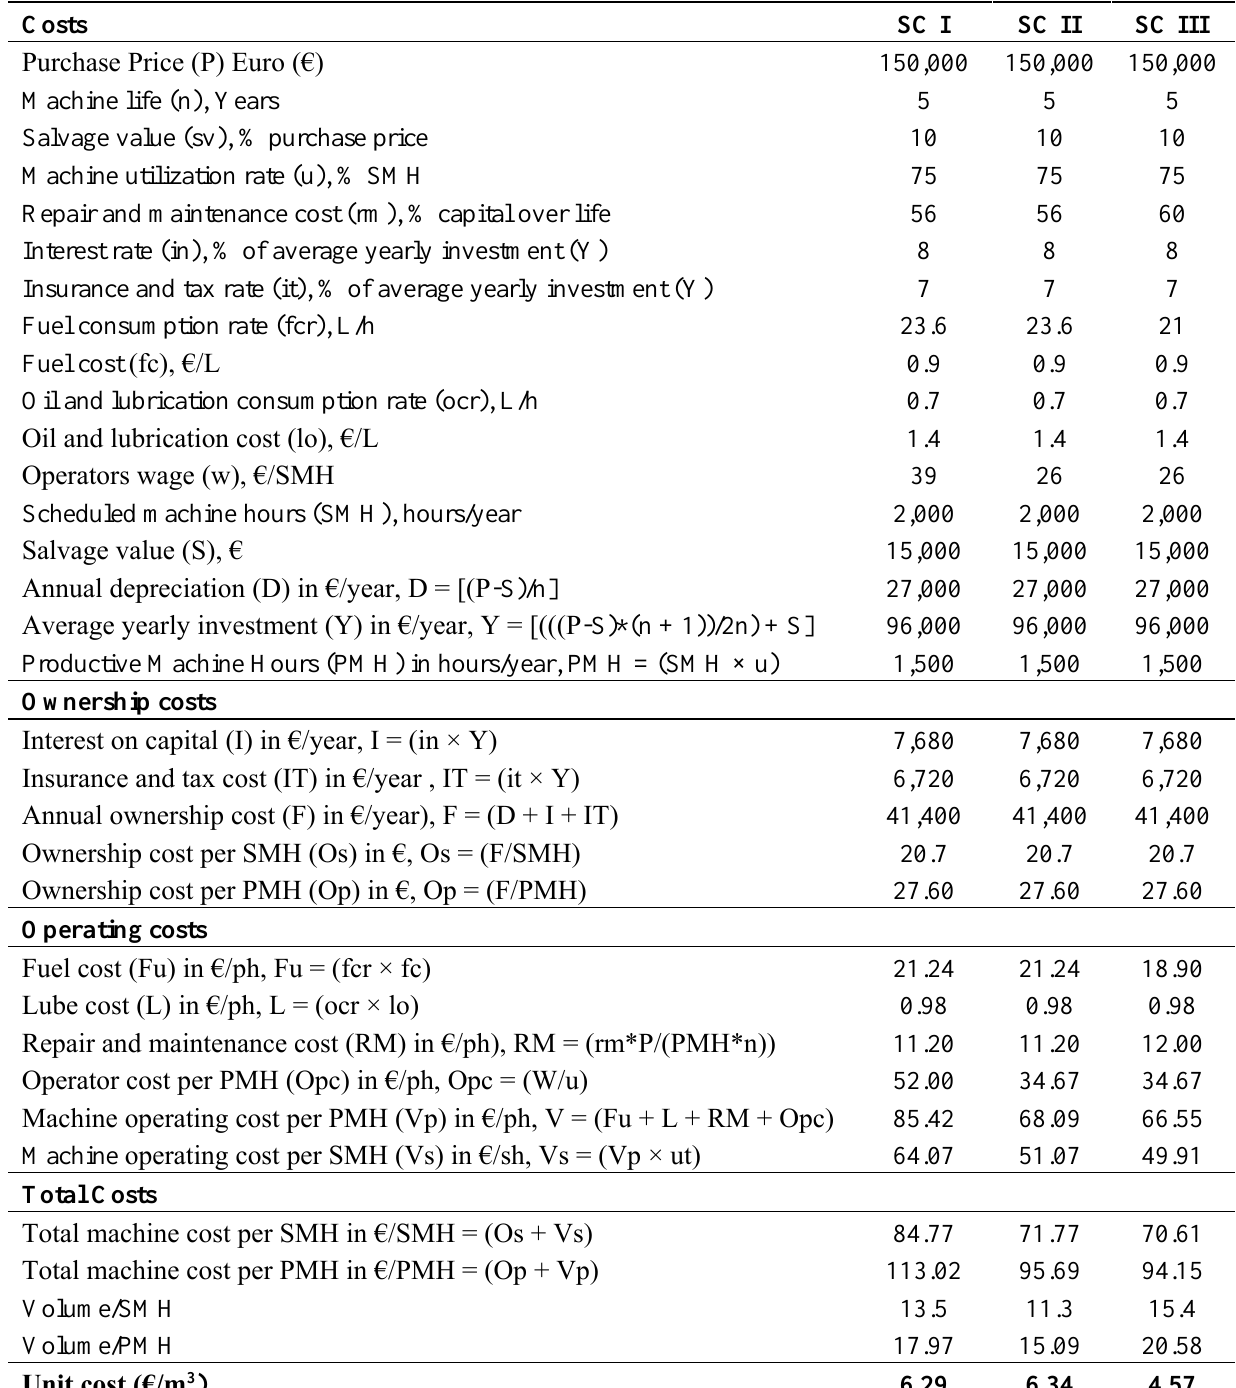
Table 2. Total machine costs per PMH and SMH for SC I, II and